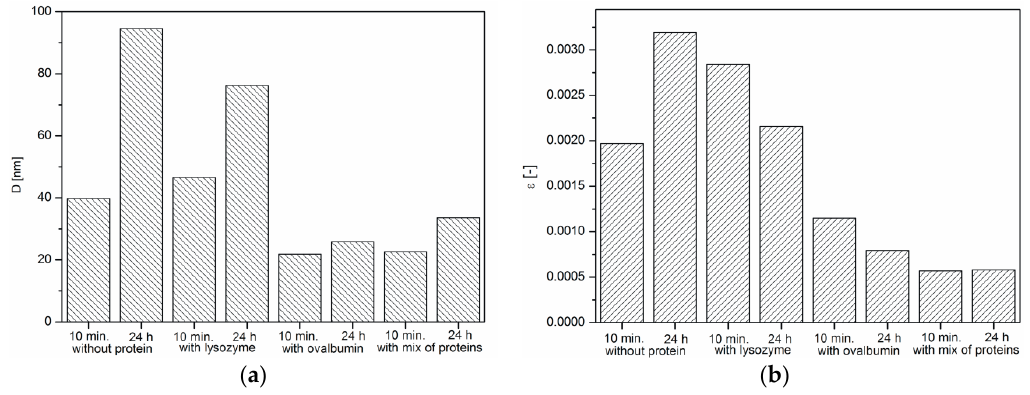
Figure 8. Changes in: ( a ) crystallite size; ( b ) microstrains. Protein concentration: 0.1%.